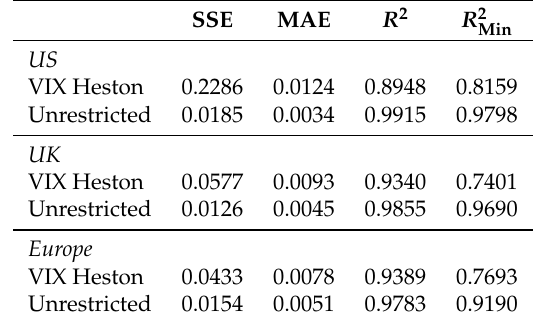
Table 2. Out-of-sample accuracy of the regression models according to the error measures defined in Equation (40).